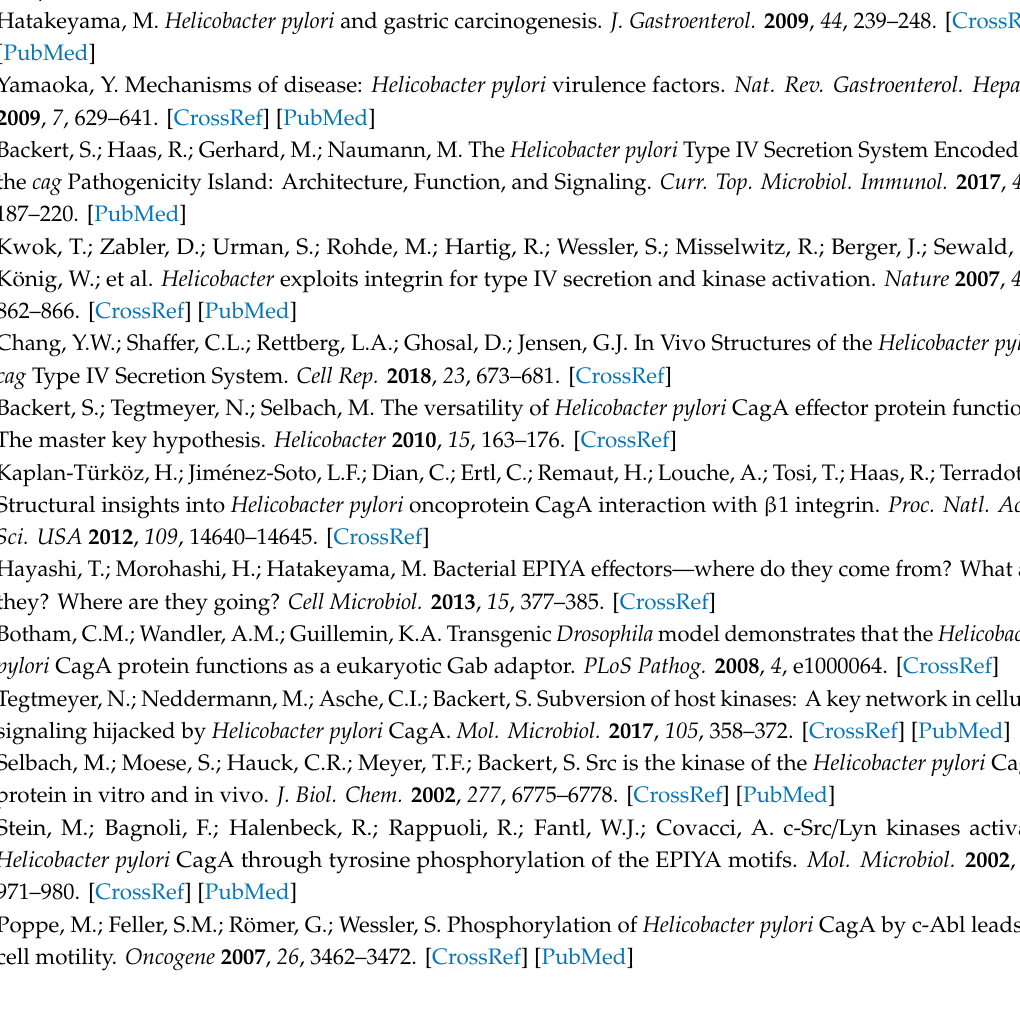
Table S1: Worldwide CagA protein sequences analyzed in the study, Figure S1: CagA EPIYA-motif phosphorylation during H. pylori infection of AGS cells was investigated using the indicated α -phosphotyrosine antibodies, Figure S2: CagA expression during H. pylori infection of AGS cells was investigated using the indicated α -CagA and α -EPIYA antibodies, Figure S3: Statistics of CagA EPIYA-motif phosphorylation and expression of CagA during H. pylori infection of AGS